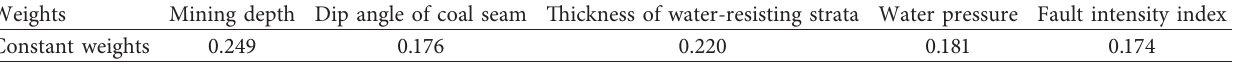
Table 3: The constant weights.